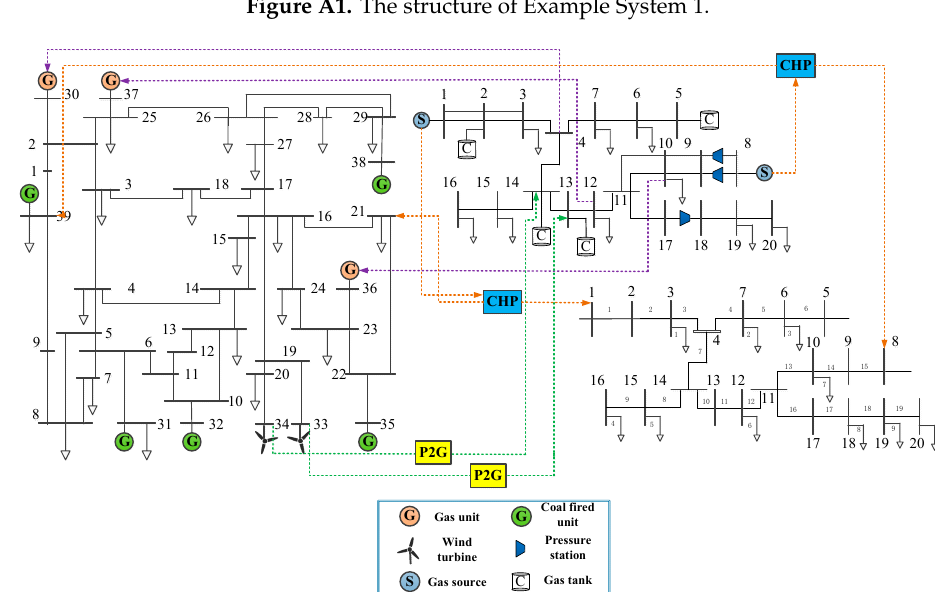
Figure A2. The structure of Example System 2. Table A1. Parameters of gas units.